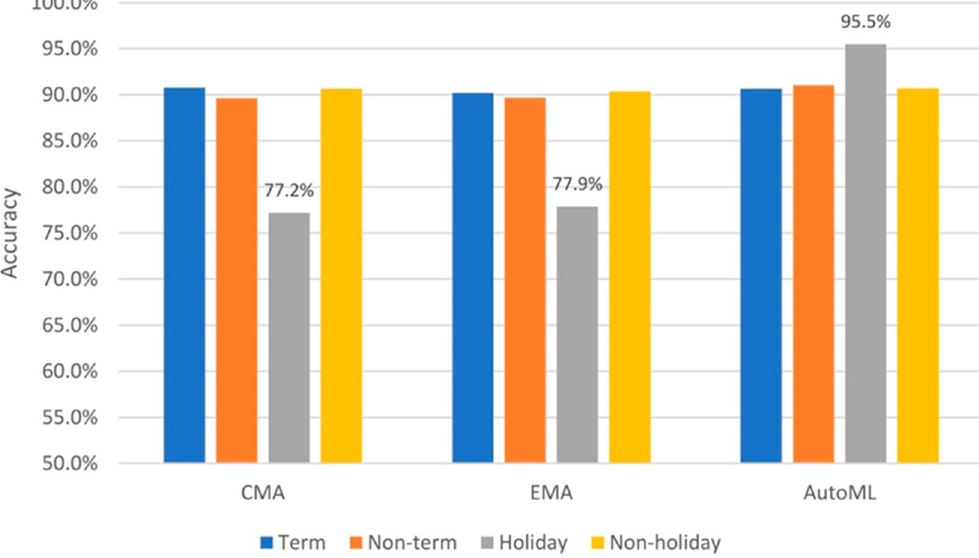
Figure 3. Accuracy of the 3 models for term/non-term periods and holiday/workdays. Data labels show accuracy for holidays.